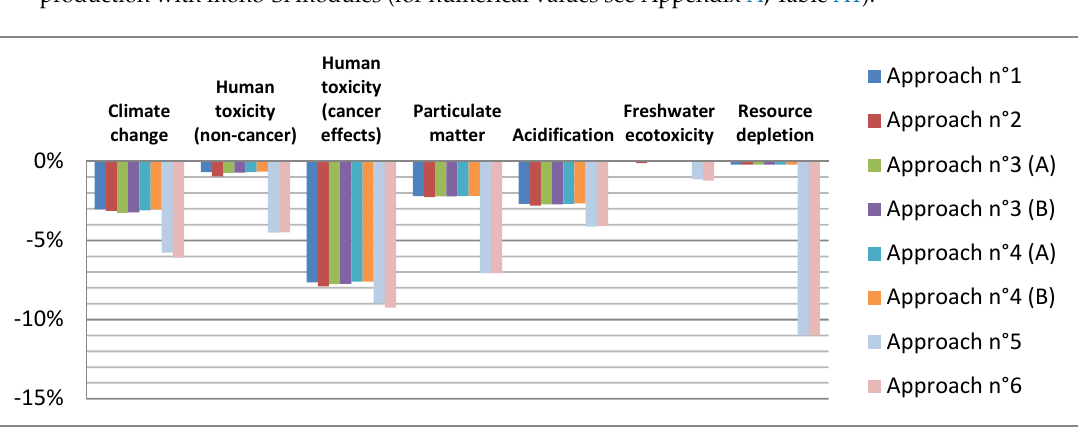
Figure 5. Potential contribution of waste management to the environmental profile of electricity production with multi-Si modules (for numerical values see Appendix A, Table A2).